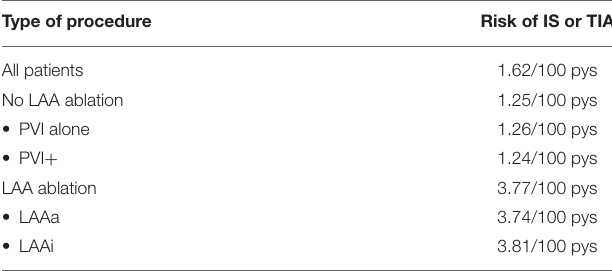
TABLE 2 | Ischemic stroke or transient ischemic attack in all